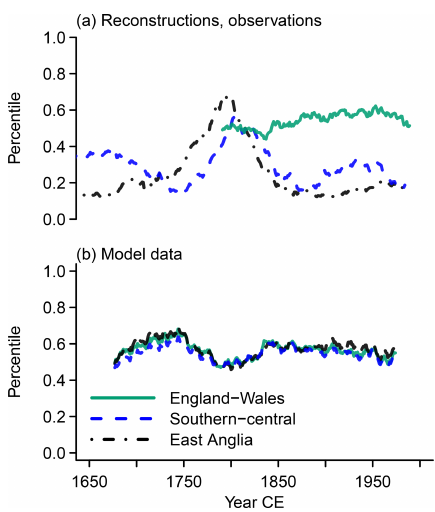
Figure 9. Visualization of how percentile values change over windows. We show what the percentile 6.7 MAMJJ precipitation amount for a reference window represents over time for England– Wales (green solid lines), southern–central England (blue dashed lines), and East Anglia (black dash-dotted lines) in (a) reconstruc- tions, observations, and (b) simulations. The reference window is centered on